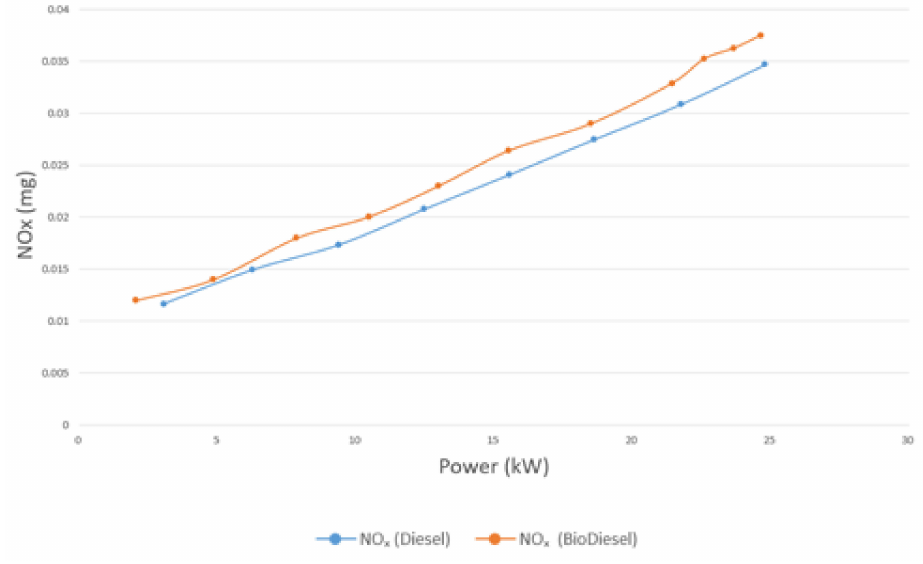
Figure 21. NOx vs.